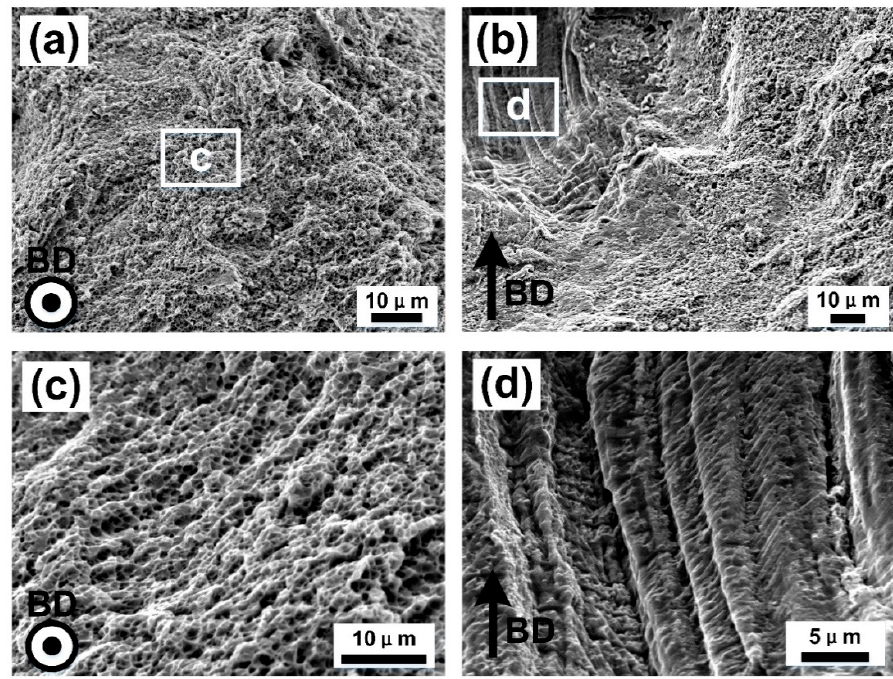
Figure 10. SEM images of fracture surfaces for SLM processed CoCrFeMnNi high-entropy alloy at room temperature. ( a , c ) were the fracture morphology of XOZ plane samples, ( b , d ) were from XOY plane samples.